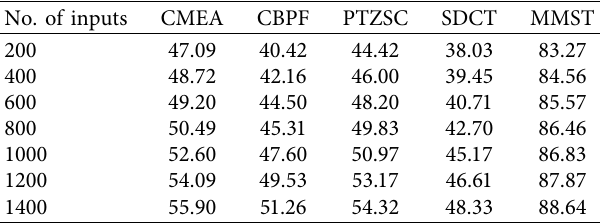
Table 3: Comparison of warm bed management.